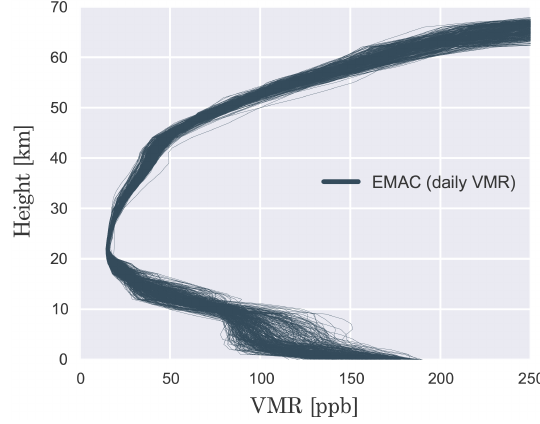
Figure 12. Simulated EMAC CO VMR profiles used in this